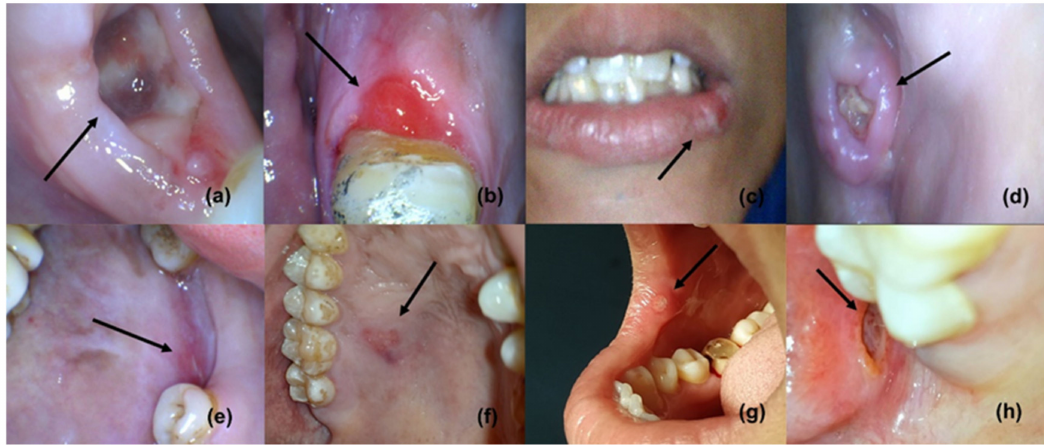
Figure 1. Oral ulcers and wounds (reproduced with permission from all authors)